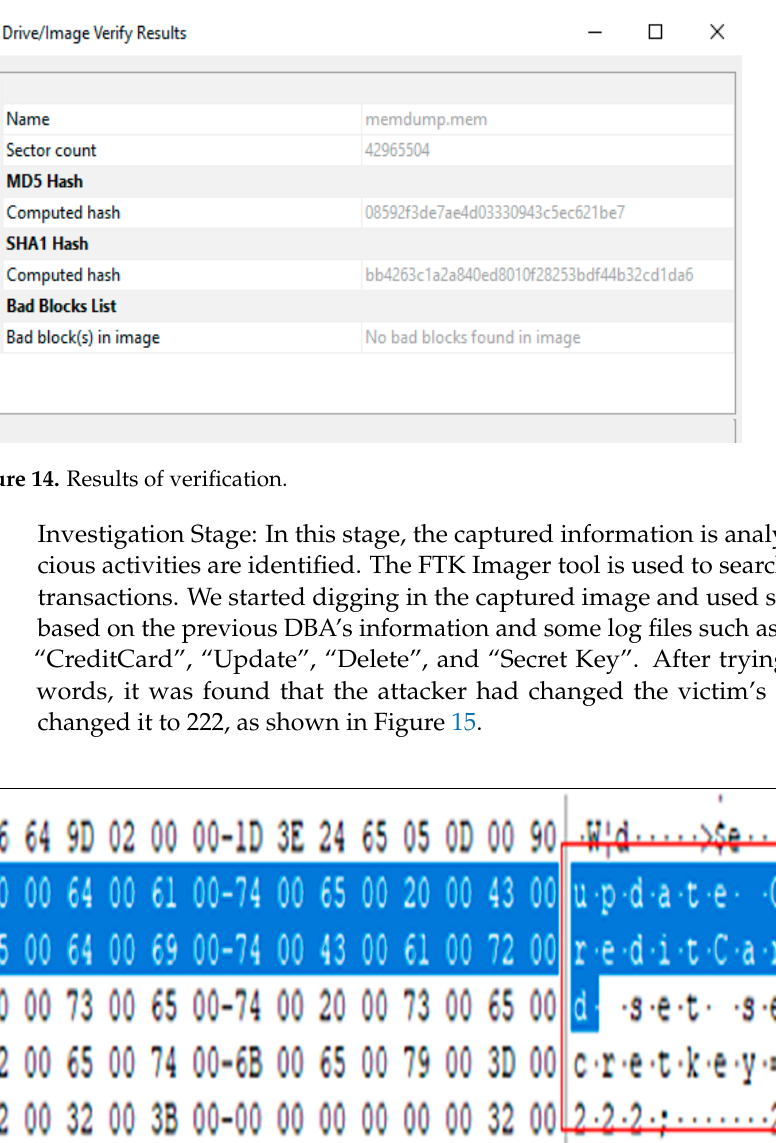
Figure 13. Hashing the captured data.